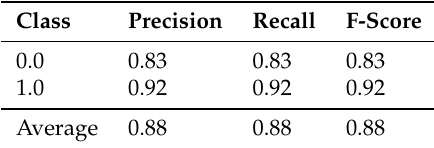
Table 2. Classification Report